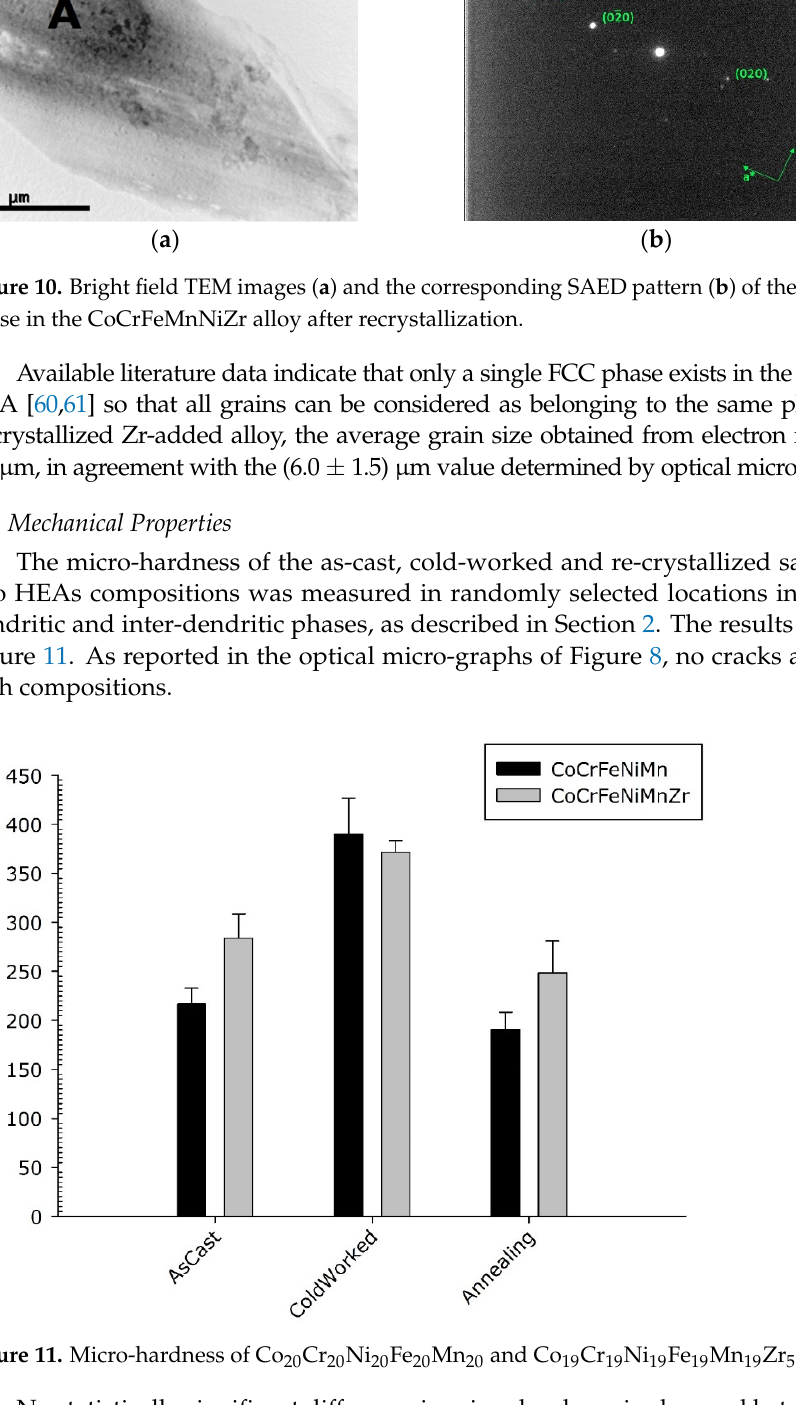
Figure 9. Bright field TEM images ( a ) and the corresponding SAED pattern ( b ) of the inter-dendritic phase in the CoCrFeMnNiZr alloy after cold working.